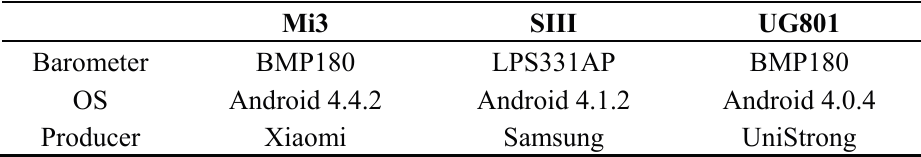
Table 1. Test phone details